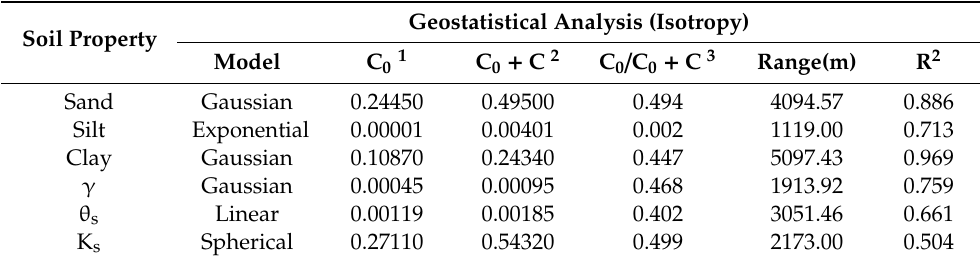
Table 3. Logarithmic variogram model of soil properties in the study area. Soil